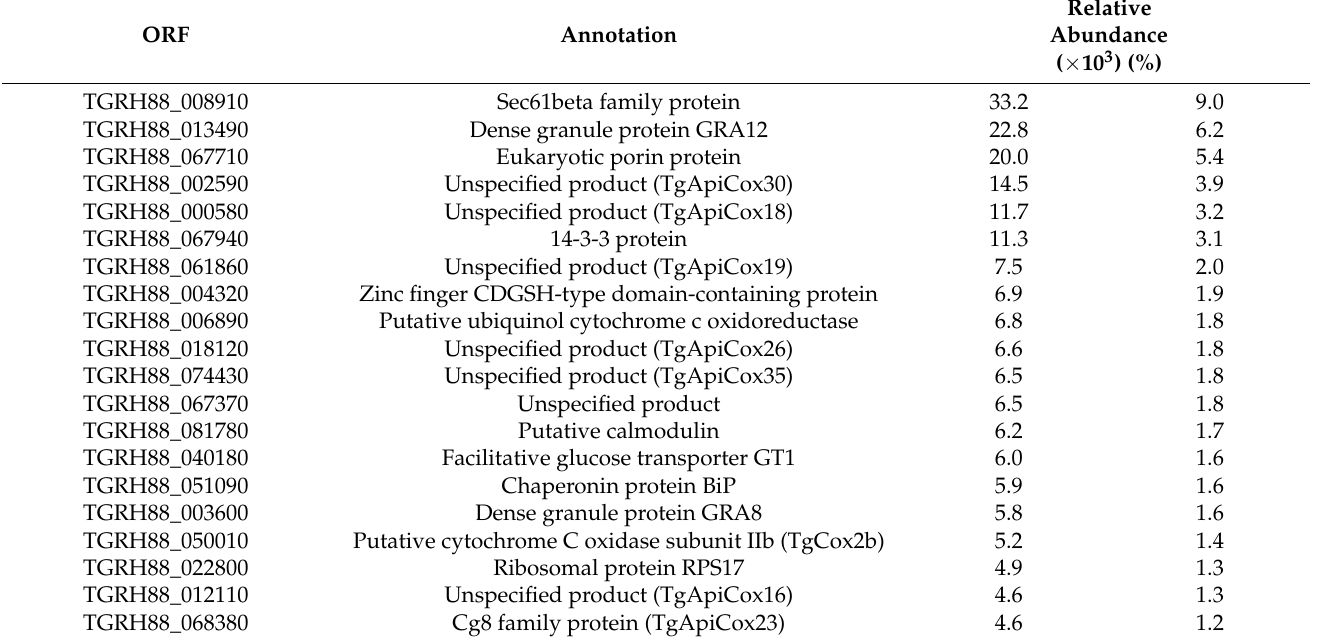
Figure 8. Venn diagram detailing the number of proteins identified in eluates from peptide 6027 (white), peptide 21,358 (light grey) or mock (dark grey) columns loaded with cell-free extracts from T. gondii RH tachyzoites or mouse spleens. The complete datasets are given in Tables S1 and S2, respectively. The twenty most abundant binding proteins specific for peptide 6027 column eluates are listed in Table 1. The complete list of the peptide 6027 specific affino-proteome is given as Supplementary Table S3. Table 1. List of the twenty most abundant peptide 6027-specific binding proteins in T. gondii RH tachyzoite cell-free extracts. The ORF numbers correspond to Toxo DB entries (www.toxodb.org, accessed 17 January 2022). Their relative abundance is given as a parameter taken from the dataset (see Tables S1 and S3), as well as the percentage of the peptide 6027 specific binding proteins. The full list of proteins is given in Table S3. The potential identity of some unspecified products was determined by BLAST searches and is provided in brackets.